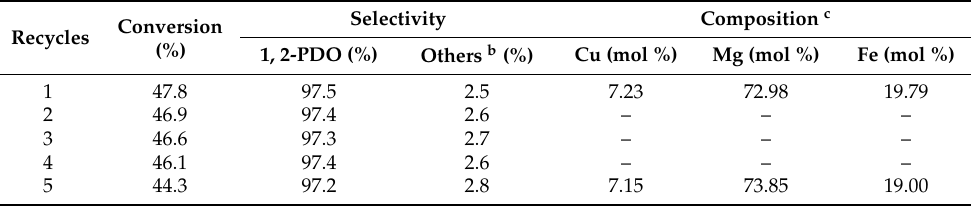
Table 5. Hydrogenolysis of glycerol and composition on recycled CuMgFe-4LDO a . Selectivity Composition Conversion Recycles (%)